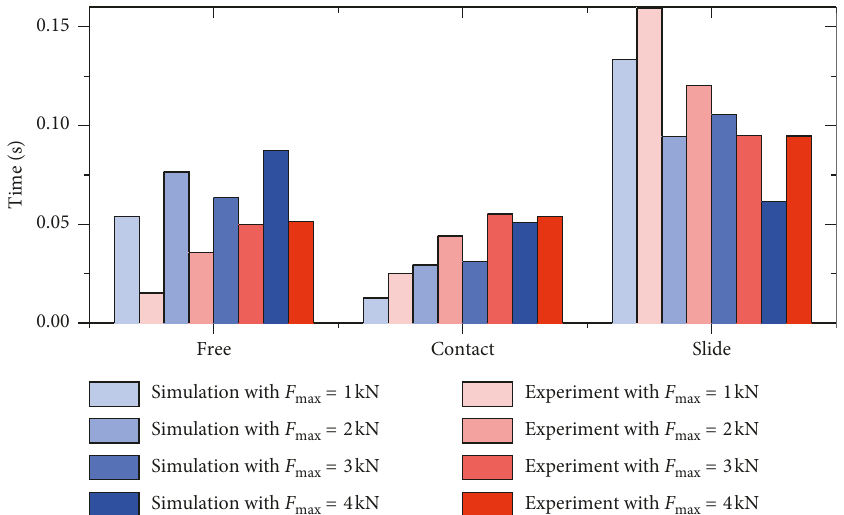
Figure 24: Statistical results of time in numerical and experimental studies with different F